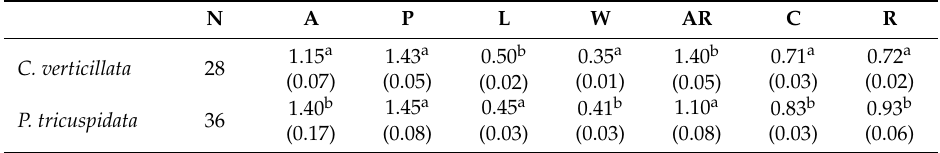
Table 5. Mean values of the area (A), perimeter (P), length of the major axis (L), length of the minor axis (W), aspect ratio (AR is the ratio L / W), circularity (C) and roundness (R) for seeds in the species C. verticillata and P. tricuspidata